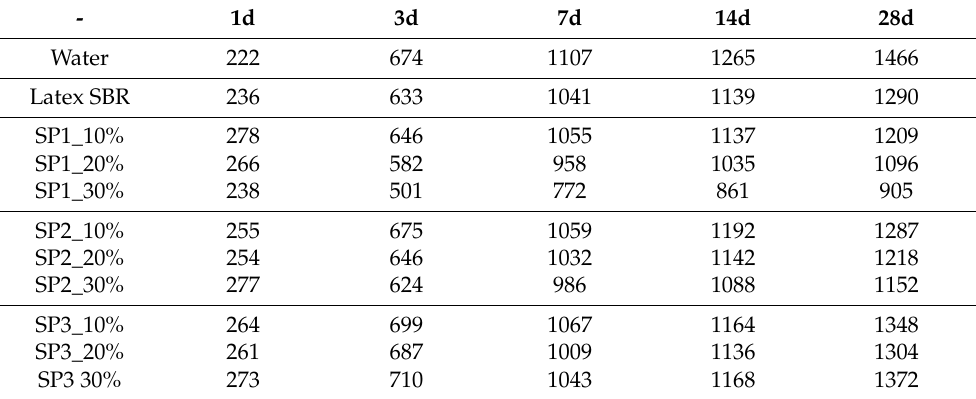
Table 5. Dry shrinkage strain in copolymer-modified cement paste (1 × 10 − 6